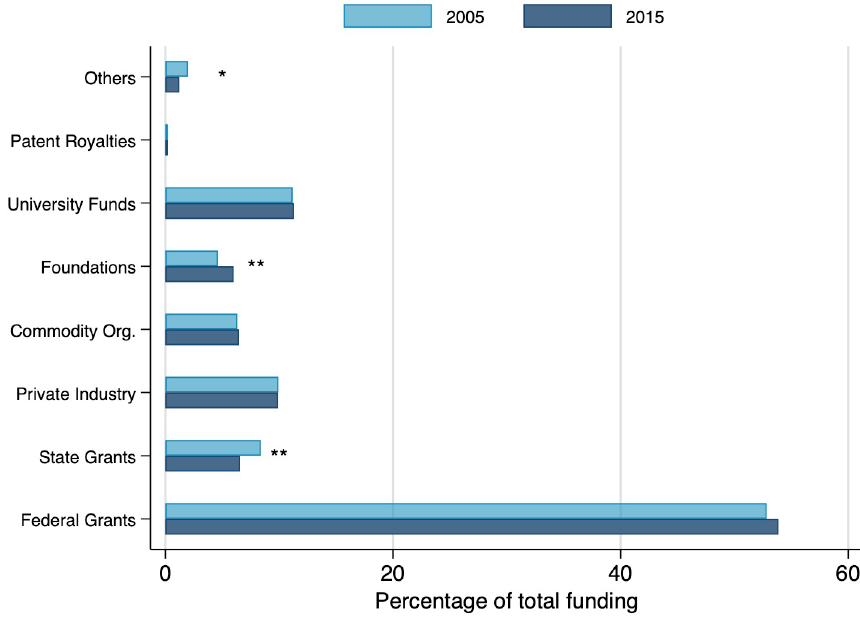
Fig 6. Distribution of total funding by source, in 2005 and 2015. Figure displays average responses for percent of funding received by each source. Average total funding—in 2005: $162,897, in 2015: $301,759. Federal grants include answers for the percentage of total funding received from: Experiment Station funds (Hatch and McIntire-Stennis), USDA competitive grants, USDA cooperative agreements, National Science Foundation (NSF), National Institutes of Health (NIH), Department of Energy (DOE), and Other federal government agencies. Statistical t-tests testing difference between years are shown in the graph. � : 10%, �� : 5%, ��� :1%. N = 1,787.